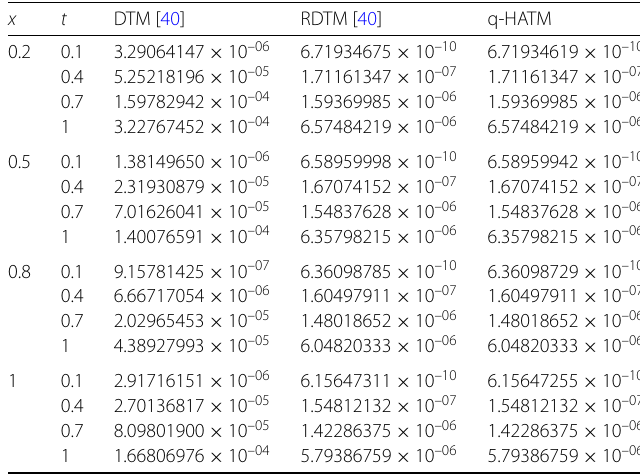
Table 6 The comparison of Q (3) solution obtained by DTM, RDTM [40], and q-HATM with the exact solution Equation (32) in terms of absolute error when α = 1, (cid:2) = –1, k = η = 0.1, p = 1.5, r = –1.5, and n = 1 for Example 4.1